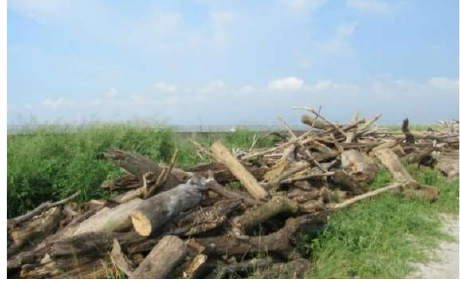
Figure 1. The driftwood in coastal Taiwan.